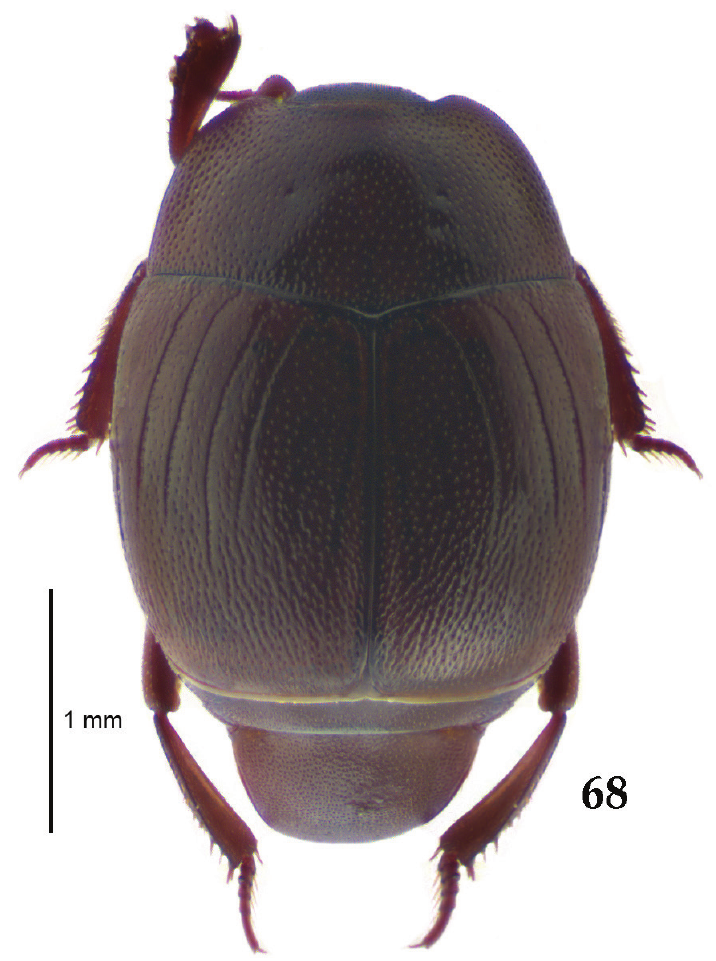
Figure 68. Gnathoncus communis (Marseul, 1862) habitus, dorsal view. Additional material examined. NEW ZEALAND. North Island. AK: 2 ♂♂ & 1 ♀ , Lynfield, 19.vi.1976, G. Kuschel (hen house) (NZAC); 1 spec., ditto, but 14.xii.1980 (chicken yard) (NZAC); 2 specs., Ranui, Henderson, 29.xi.1955, K.A.J. Wise (ex debris in poultry feed shed) (NZAC); 1 ♂ , 1 ♀ & 1 spec., Tropicana Dr., 19.vi.1976, G. Kuschel (hen house) (NZAC); 1 spec., ditto, but 14.viii.1976 (NZAC); 7 ♂♂ & 3 ♀♀ , Mahinerang, 26.i.1977, J. Painter ( Sturnus vulgaris nest) (NZAC); 3 ♂♂ & 3 ♀♀ , Kumeu, 21.vi.1975, J.C.Watt (ex fowl manure) (NZAC). BP: 1 ♂ , Tau- ranga, 13.xi.1976, R.J. Ball (on plant) (NZAC). HB: 2 specs., Longlands, ii.1976, J.A. McKeenan (ex starling nest) (NZAC); 1 spec., Havelock North, 14.xi.1977, collector unknown (on large Pinus sp., ex nest of Sturnus vulgaris ) (NZAC); 2 ♂♂ & 3 ♀♀ , Graeme Friis’ Farm, Twyford, 2.xi.1976, B.A. Holloway (poultry manure)